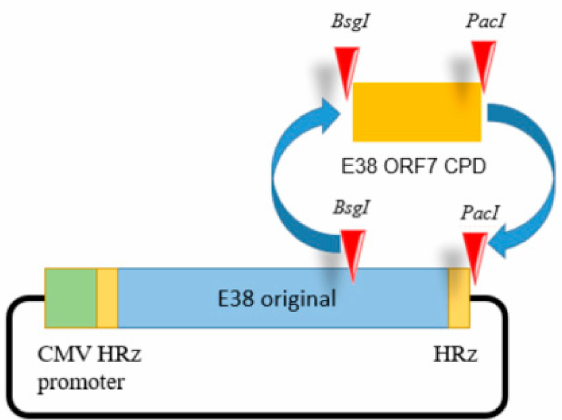
Figure 1. The E38-ORF7 CPD infectious clone containing the CMV promoter. The ORF7 fragment of the original E38 virus was replaced by the ORF7 attenuated fragment generated by CPD at the BsgI and PacI restriction sites. The presence of the ORF7 attenuated fragment was confirmed using